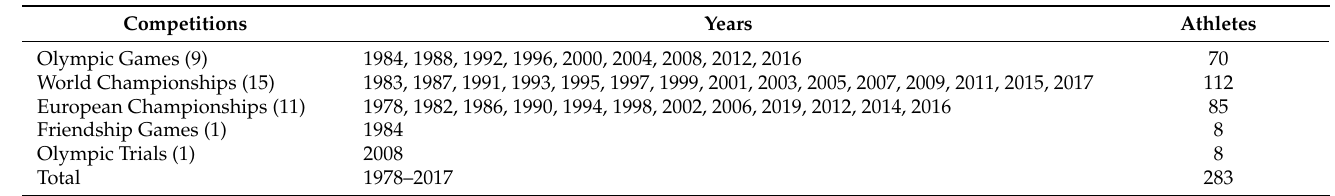
Table 1. Types of competitions, years of the competition, and the number of competitors participating in the final of the 400 mH